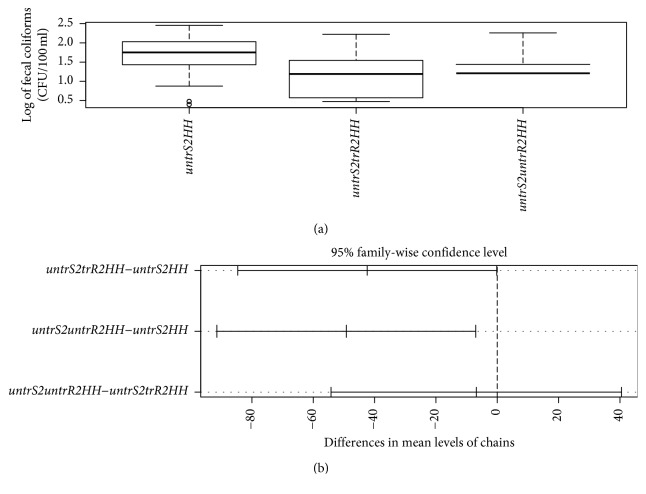
Boxplot (a) and pairwise comparison (b) of fecal coliforms counts (CFU/100 mls) in various water-handling chains (untrS2HH = untreated source to households; untrS2trR2HH = untreated source to treated reservoir to households; untrS2untrR2HH = untreated source to untreated reservoir to households).